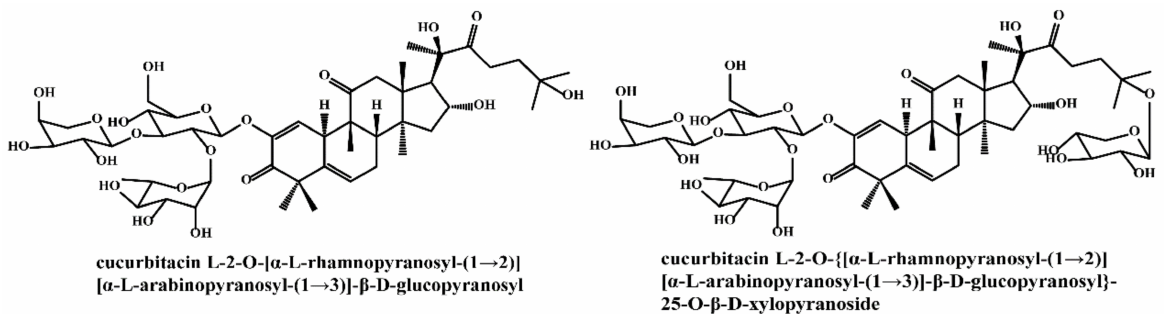
Figure 3. Structures of two cucurbitane-type